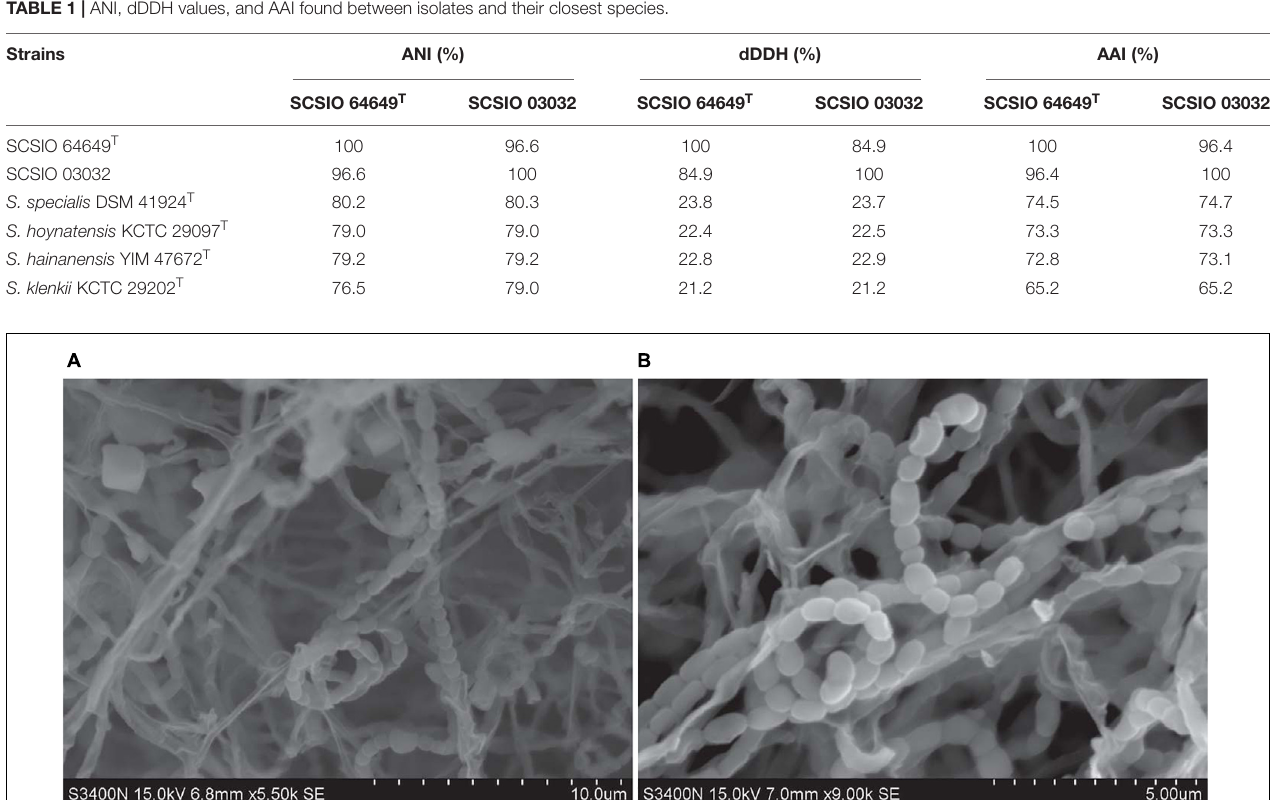
FIGURE 3 | Scanning transmission electron microscope images show the cell morphology of strains SCSIO 64649 T (A) and SCSIO 03032 (B) after incubation on ISP 2 medium for 14 days at 28 ◦